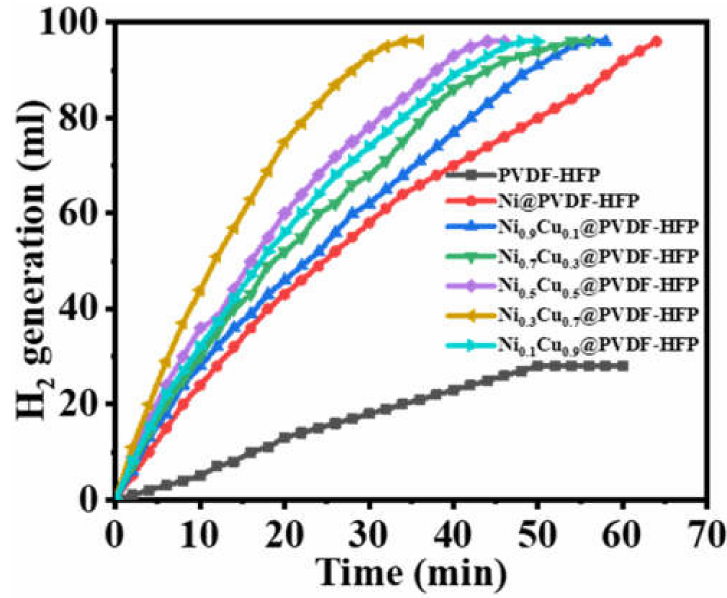
Figure 6. Influence of Ni x Cu 1 − x /PVDF-HFP NF membranes on H 2 production from SBH hydrolysis at 100 mg catalyst, 1 mmol [SBH], and 298 K.